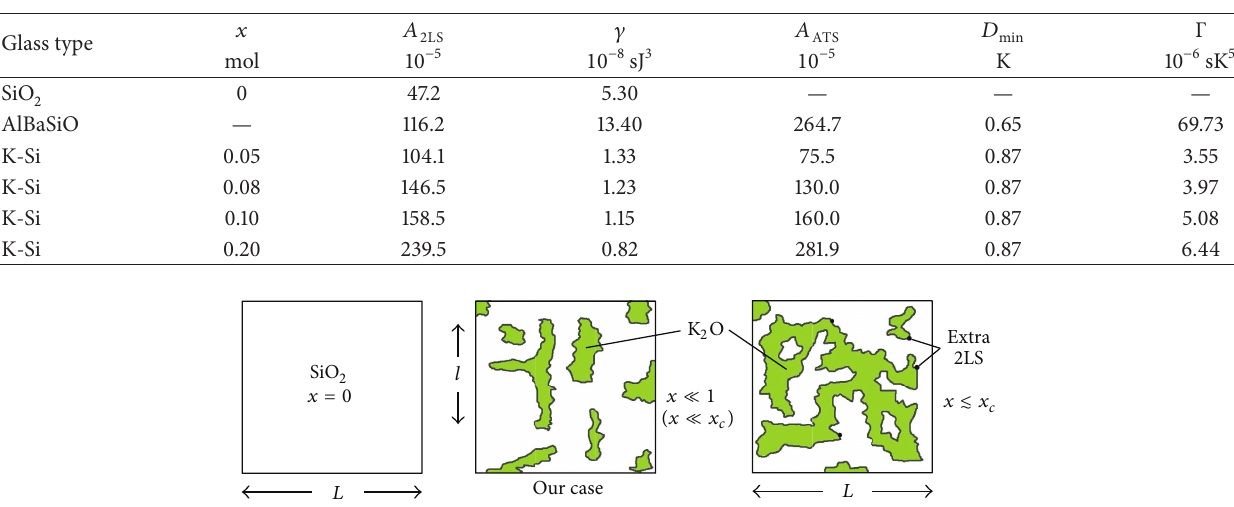
O ) 𝑥 glasses. In all of the best fits, we have employed the values 2